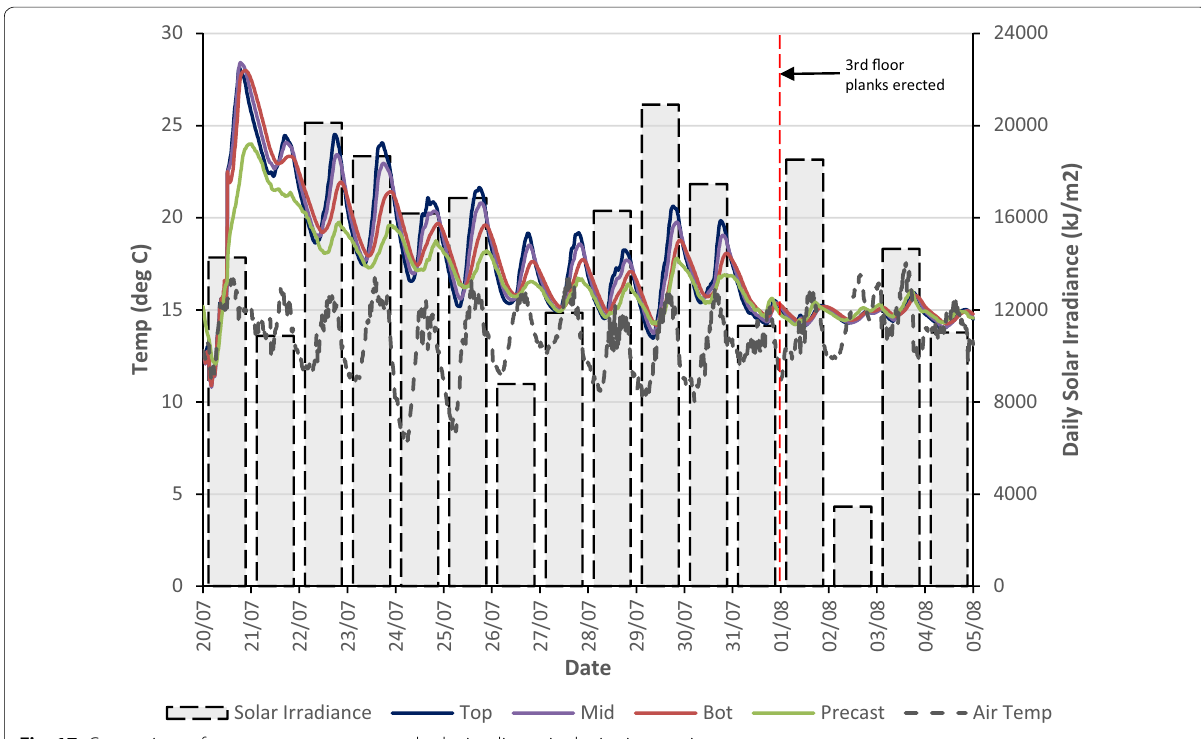
Fig. 17 Comparison of concrete temperature and solar irradiance in the in situ